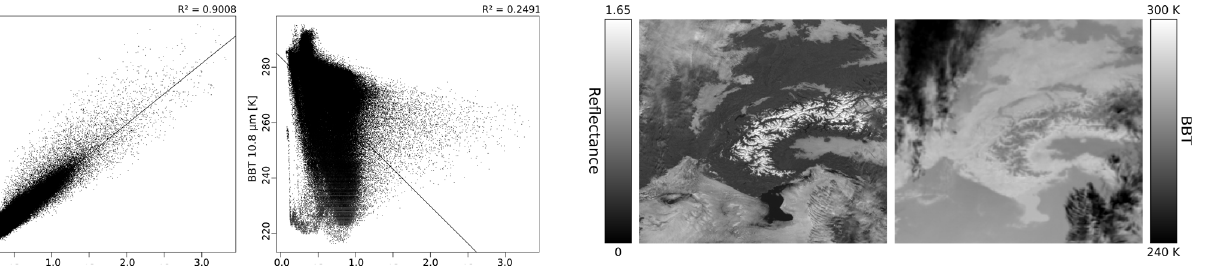
Fig. 3. HRV reflectance (left) and 10.8µm BBT (right) for a section of the SEVIRI scene from 17 January 2011 showing the Alps in the center of the image and Mediterranean Sea in the south.